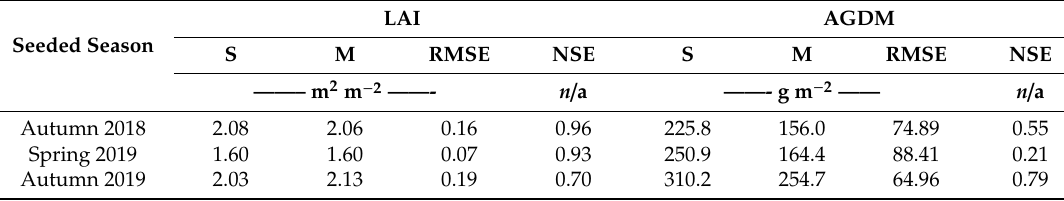
Figure 7. Simulated (S) versus measured (M) leaf area index (LAI) and above ground dry mass (AGDM) ( a , c ) and comparison between simulated and measured grain yields ( b , d ) of autumn-sown ( a , b ) and spring-sown ( c , d ) barely for model validation at Gyeongsang National University, Jinju, South Korea in 2019. Vertical bars represent standard deviation of each mean value ( n = 3) at 95% confidence intervals in subplots ( a , b ) and SE of each mean value ( n = 3) in subplots ( b , d ). Table 3. Error statistics of root mean square (RMSE) and Nash–Sutcli ff e e ffi ciency (NSE) between the simulated (S) and measured (M) values of leaf area index (LAI) of Heenchal seeded in spring and autumn at Gyeongsang National University (GNU), Jinju, South Korea in 2018 and 2019 for model